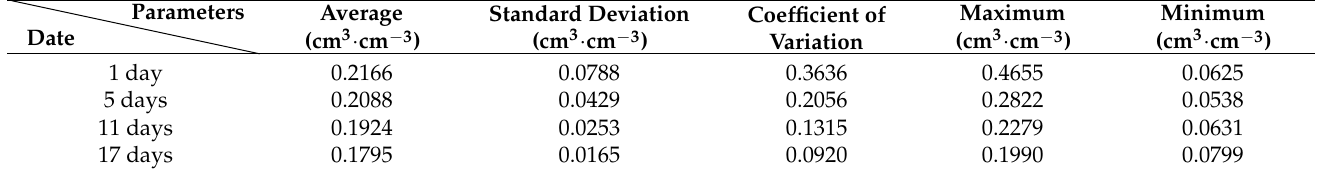
Table 6. Calculation of statistical indexes of daily soil moisture content for water storage pit irrigation.